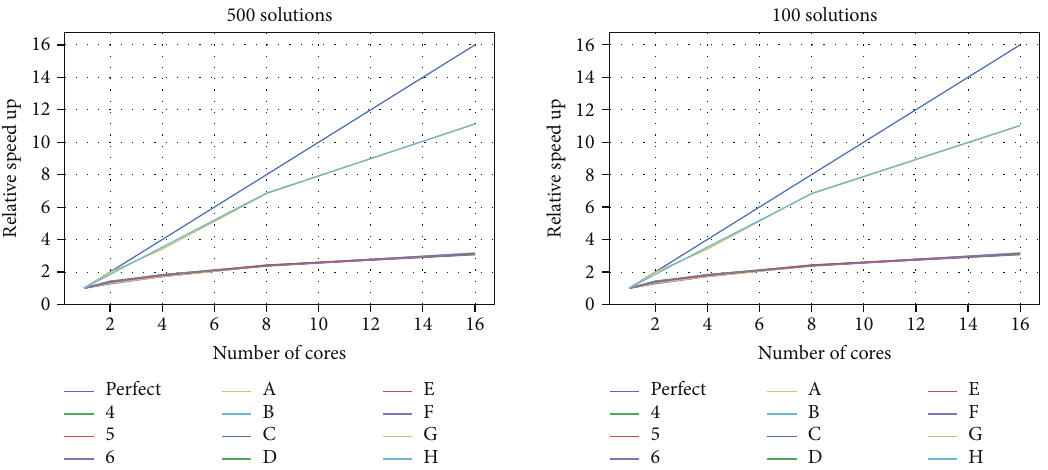
Figure 9: Speed up charts for 100 and 500